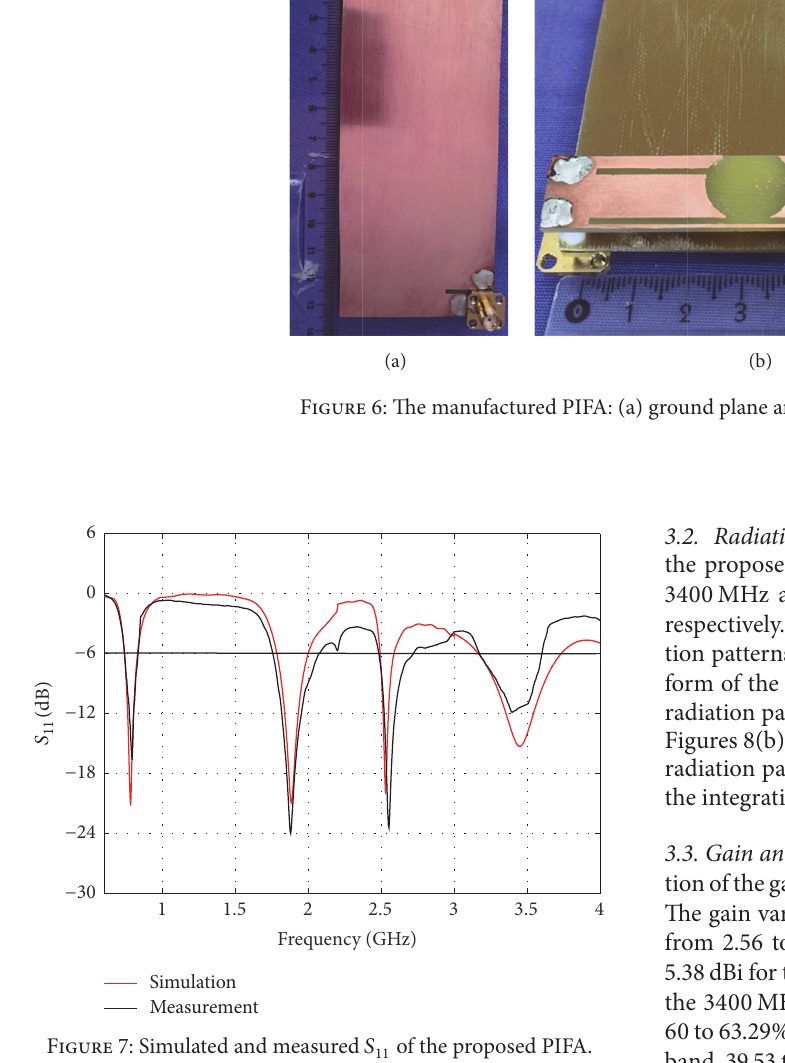
measured using the Vector Network Analyzer and compared with the simulated reflection coefficient in Figure 7. From this figure, we observed a good agreement between the simulated and measured results. A shift in bands #3 and #4 is mainly due to the measurement environment and manufacturing